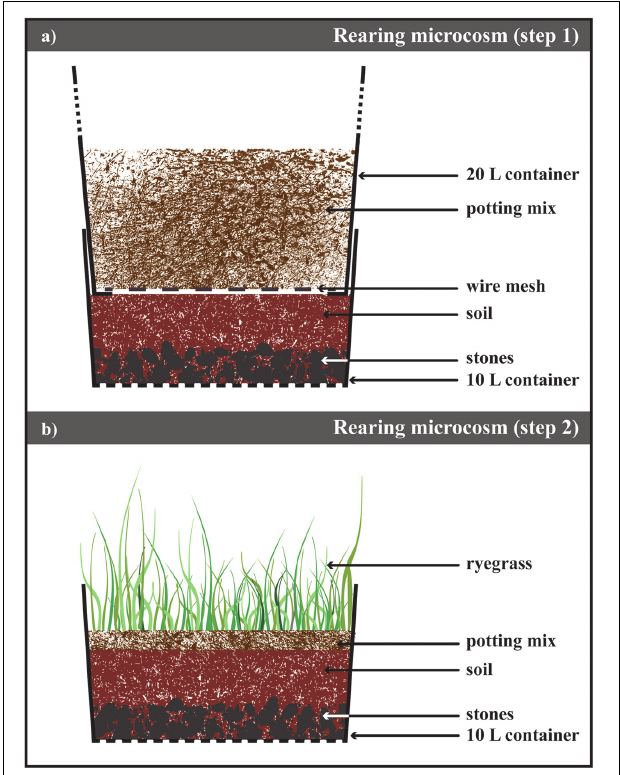
FIGURE 2 | Laboratory rearing of Heteronychus arator . (a) Schematic drawing of the microsm used to rear H. arator from eggs to beetles. It consisted of two containers inserted one into the other. The bottom of the top container was replace with a metal mesh allowing the beetles move to the bottom one containing soil from the field site of the insect collection and stones to ensure the drainage of the excess water. (b) After 2 weeks, the top container was removed and ryegrass sawn on a layer of potting mix. This microcosms were stored until adult